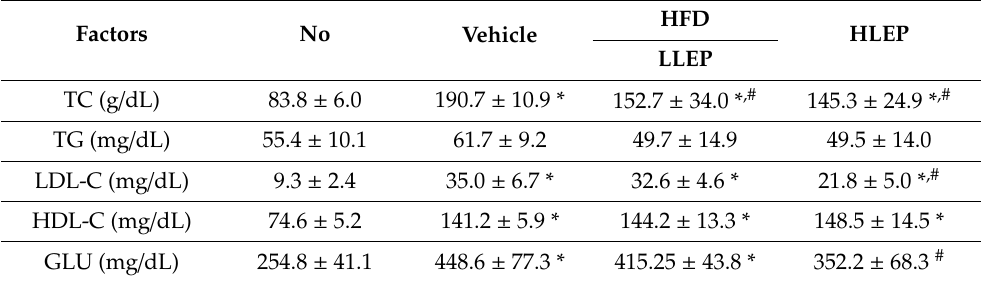
Table 1. Concentration of TC, TG, LDL-C, HDL-C, and GLU in serum.